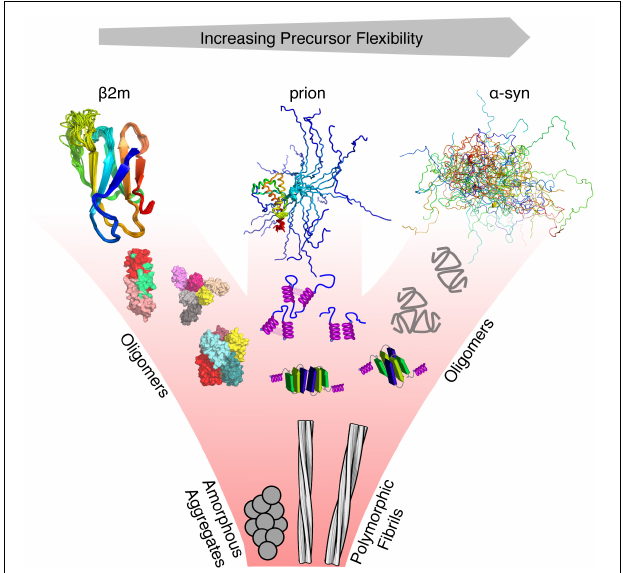
FIGURE 1 | Protein misfolding and flexibility. Examples of proteins with different degrees of flexibility ( α -synuclein—IDP, prion protein –folded and IDR, and β 2 m—folded), each of which aggregate to form amyloid fibrils. For each class of protein, its structure cannot be represented by a single conformation, as each interconverts between various conformers on different timescales. Hence, the conformational properties of these proteins are best described using an ensemble of protein states guided by different types of experimental restraints. Oligomers that form from these precursors may retain the structure of the monomer, convert to a different structure, or form new structures not accessible to their precursors. All eventually form the cross- β fold of amyloid which, whilst containing a canonical parallel in-register β -strand structure can adopt a variety of different structures (127 different amyloid structures have been collated in the amyloid atlas; Sawaya et al.,